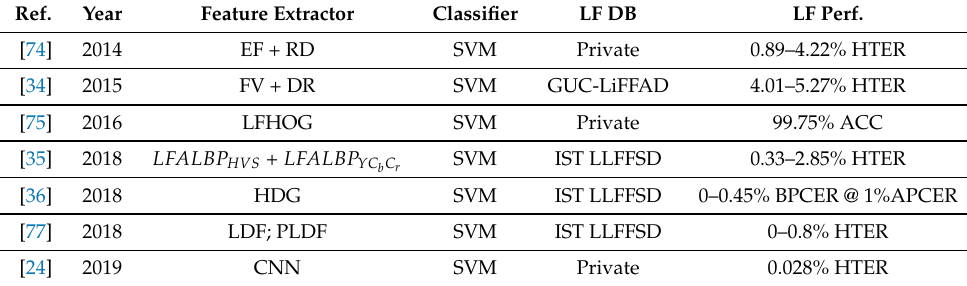
Table 8. Summary of presentation attack detection methods. table: EF—edge feature; RD—ray-difference image; FV—focus variation; DR—decision rule; LFHOG—light-field histogram of oriented gradients; LFALBP—light-field angular local binary pattern; HDG—histogram of disparity gradients; LDF—landmark depth feature; PLDF—principal landmark depth feature; CNN—convolutional neural networks; SVM—support vector machine; GUC-LiFFAD—GUC Light-Field Face Artefact Database; IST LLFFSD—IST Lenslet Light-Field Face Spoofing